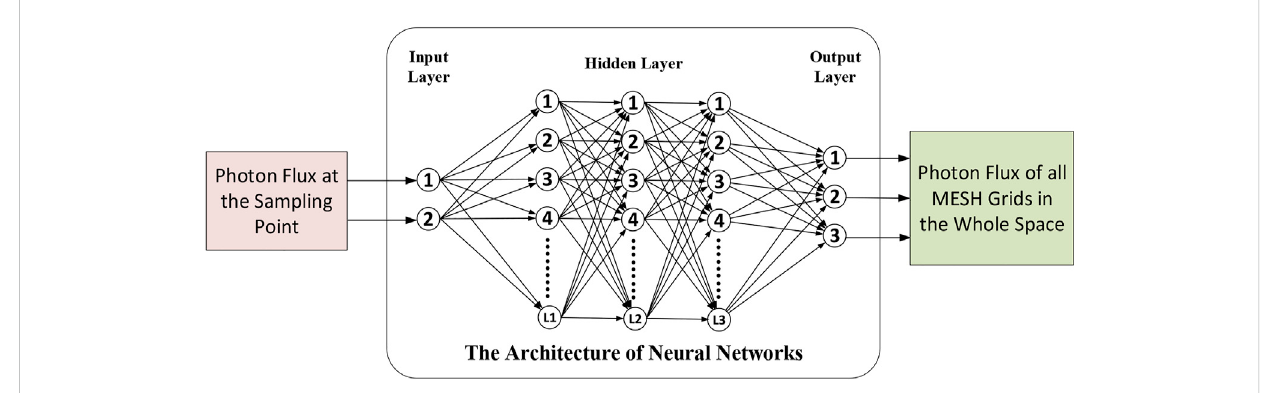
FIGURE 3 Schematic diagram of the fi ve-layer MLP